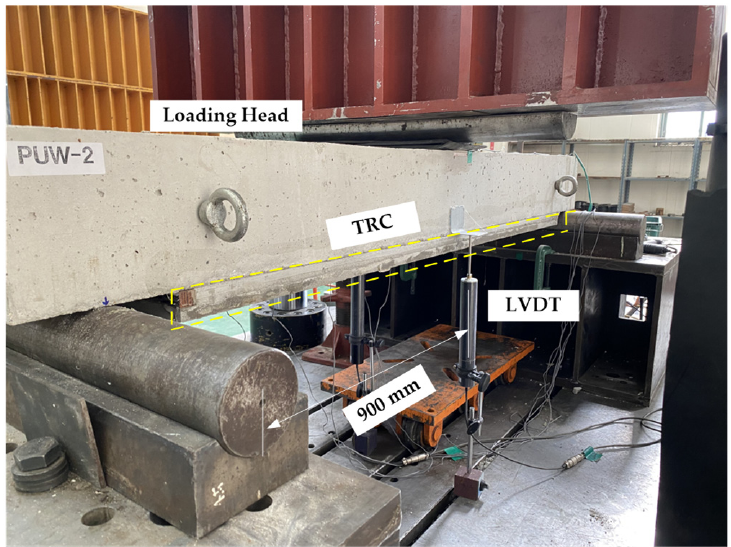
Figure 12. Flexural test set-up and instrumentation.